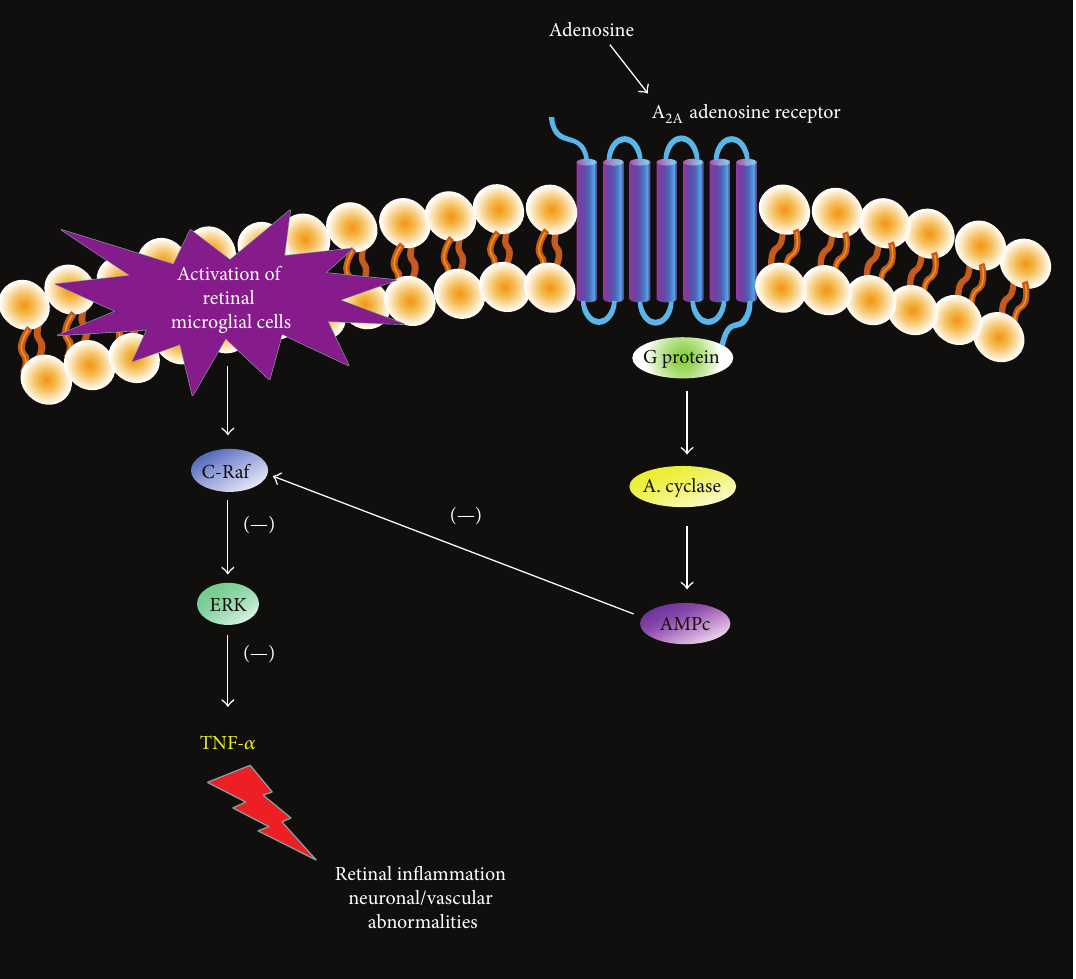
Figure 2: Regulation of retinal inflammation by A 2 adenosine receptor in the retinal microglial cells during pathologies such as diabetes or traumatic optic neuropathy. A 2 activation reduces TNF- 𝛼 release by repressing the inflammatory cascade C-Raf/ERK in activated retinal